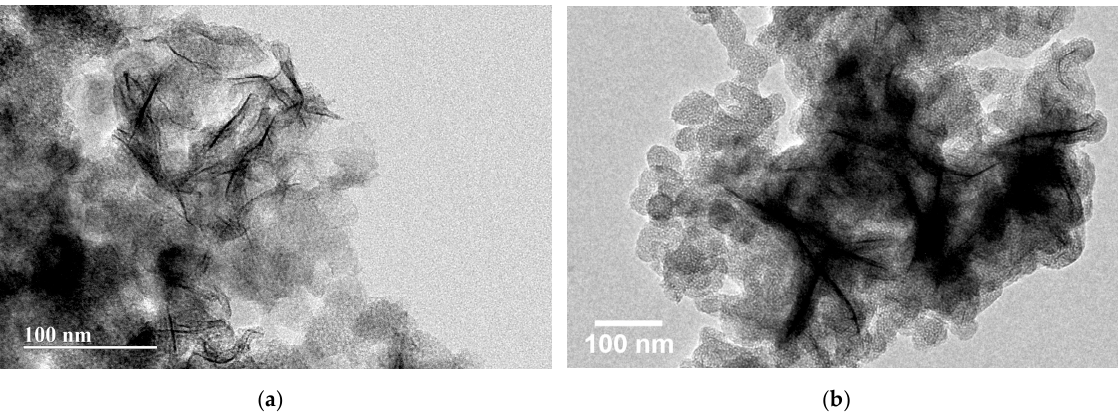
Figure 9. HRTEM images for the calcined Ce-MCM-Cl ( a ) and Ce-MCM-NO 3 ( b )